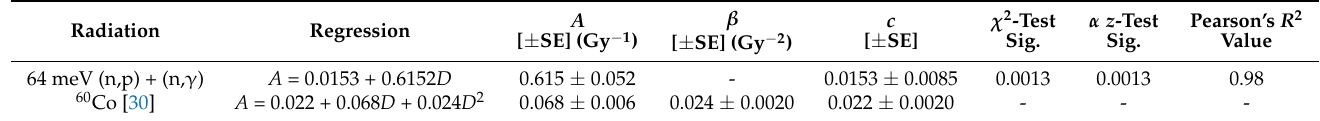
Table 5. CBMN linear dose response regression for 64 meV thermal neutrons and 60 Co